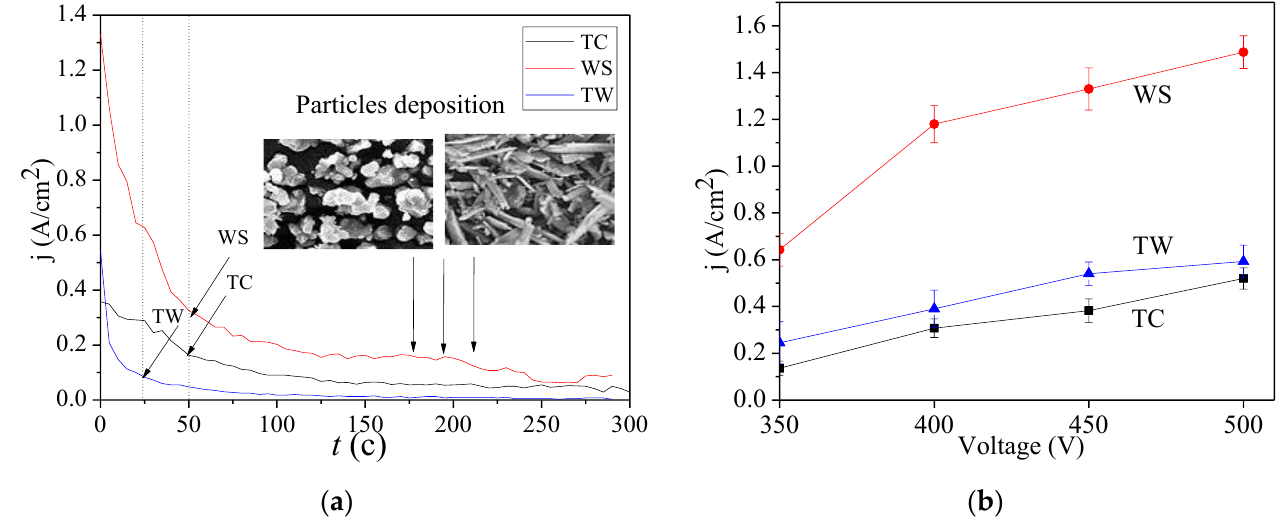
Figure 3. ( a ) Graphs of the current density versus the time of the TC, WS, and TW coatings deposition at 400 V; ( b ) graphs of the initial current density versus the voltages of the coating’s deposition. This can be explained by the fact that wollastonite was a more low-melting compound than TCP. Wollastonite transformed into pseudo-wollastonite at 1125 °C [29] and melted at 1544 °C [49]. As for TCP, at a temperature of about 1125 °C β -TCP transformed into α -TCP [50], which passed into the α ‘phase at 1440 °C. The melting point of α ‘ phase was 1756 °C [51].